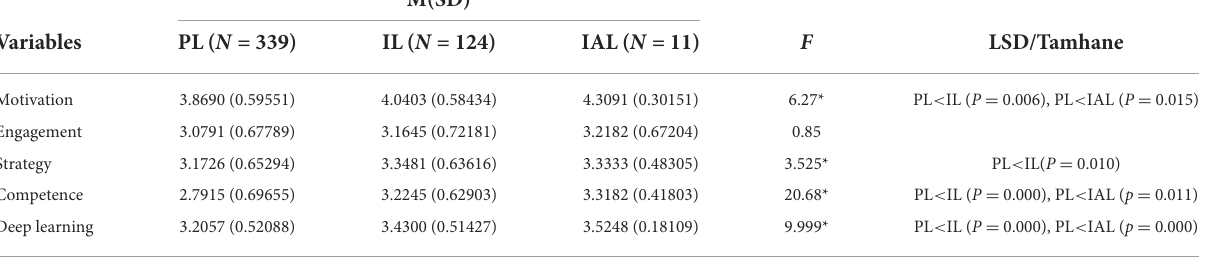
TABLE 8 ANOVA for comparison of students’ deep learning across English proficiency groups.